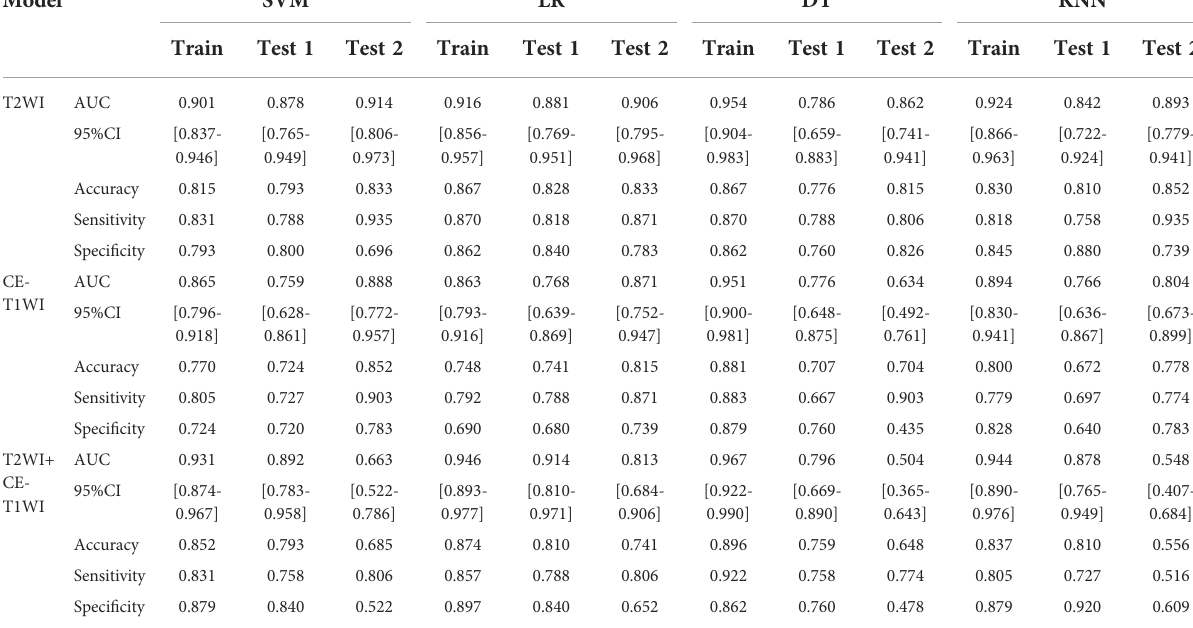
TABLE 4 Predictive ef fi cacies of different machine learning models. Model